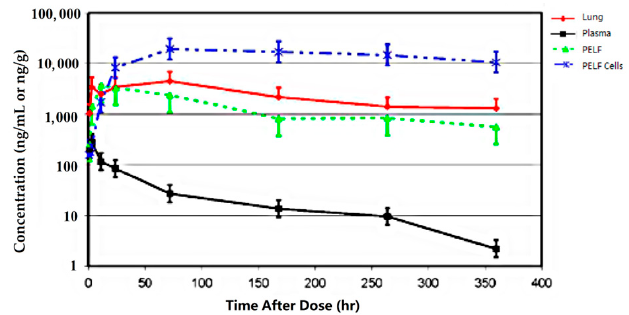
Figure 5. Tulathromycin concentrations for 360 h following a single 2.5 mg/kg IM dose to cattle (Modified from Cox et al. [48]).